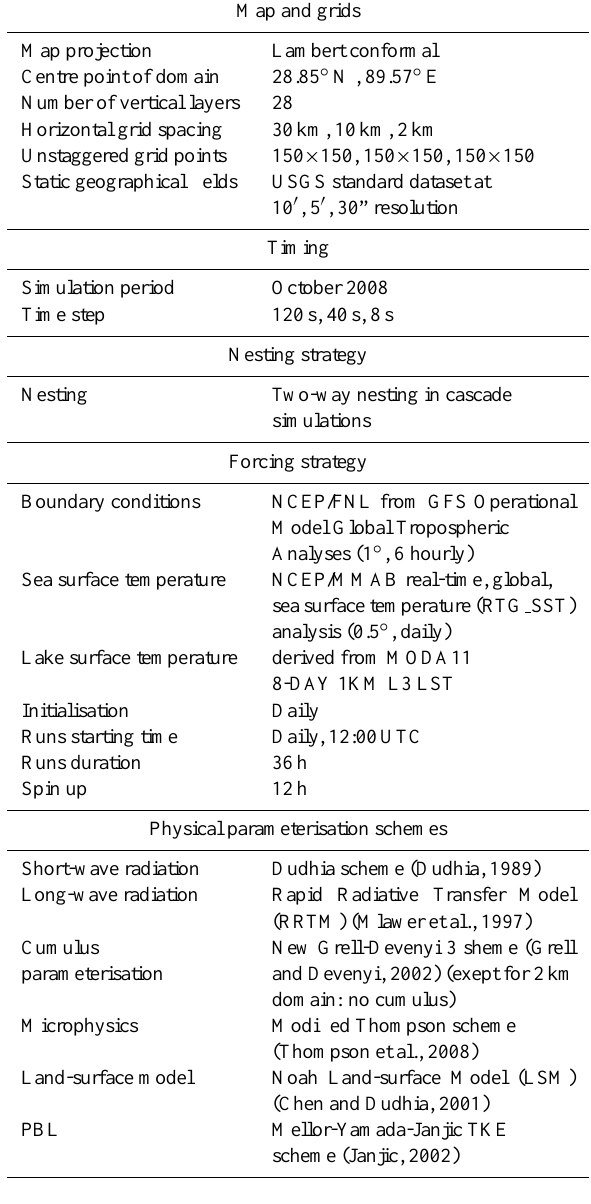
Table 1. Design of the reference experiment